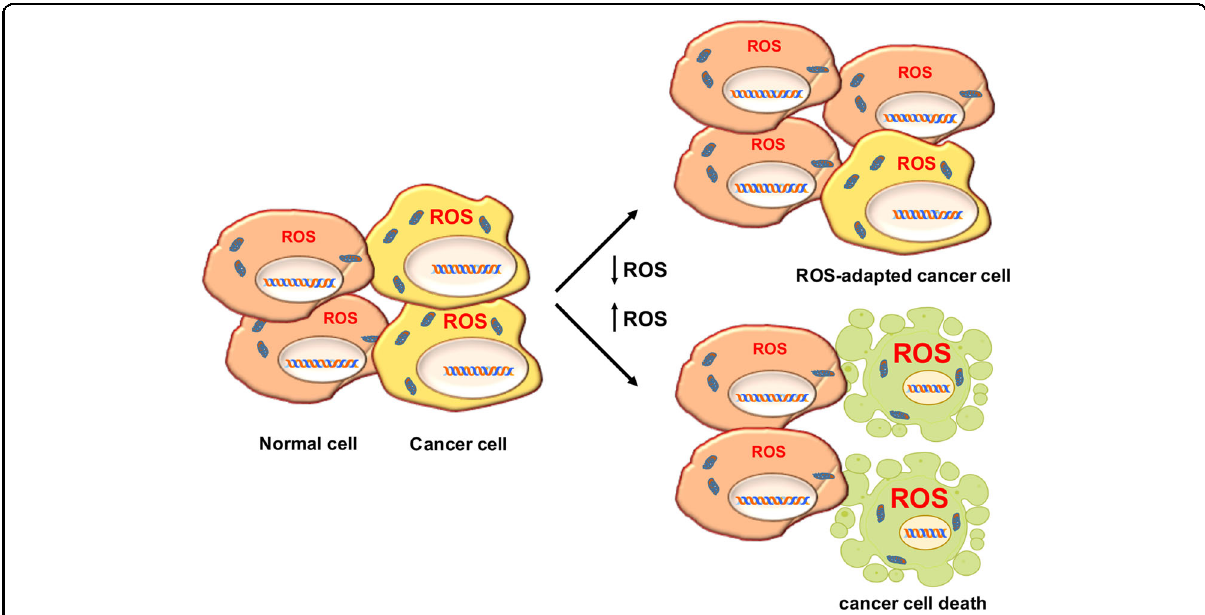
Fig. 4 The two possible ROS-related anticancer therapeutic strategies. The fi rst approach is based on lowering ROS levels to counteract their role in cellular transformation; it is aimed at reducing the number of transformed cells by depriving them of fuel (represented in the upper right side of the fi gure as a lower proportion of transformed cells with respect to that of normal cells). The second approach is based on the consideration that cancer cells, with an antioxidant system already triggered, are more sensitive than their normal counterparts to further increases in ROS and are unable to achieve redox balance. Therefore, by inducing ROS under these metabolic conditions, a high percentage of the cells undergo death (represented in the lower right side of the fi gure, where transformed cells are depicted as